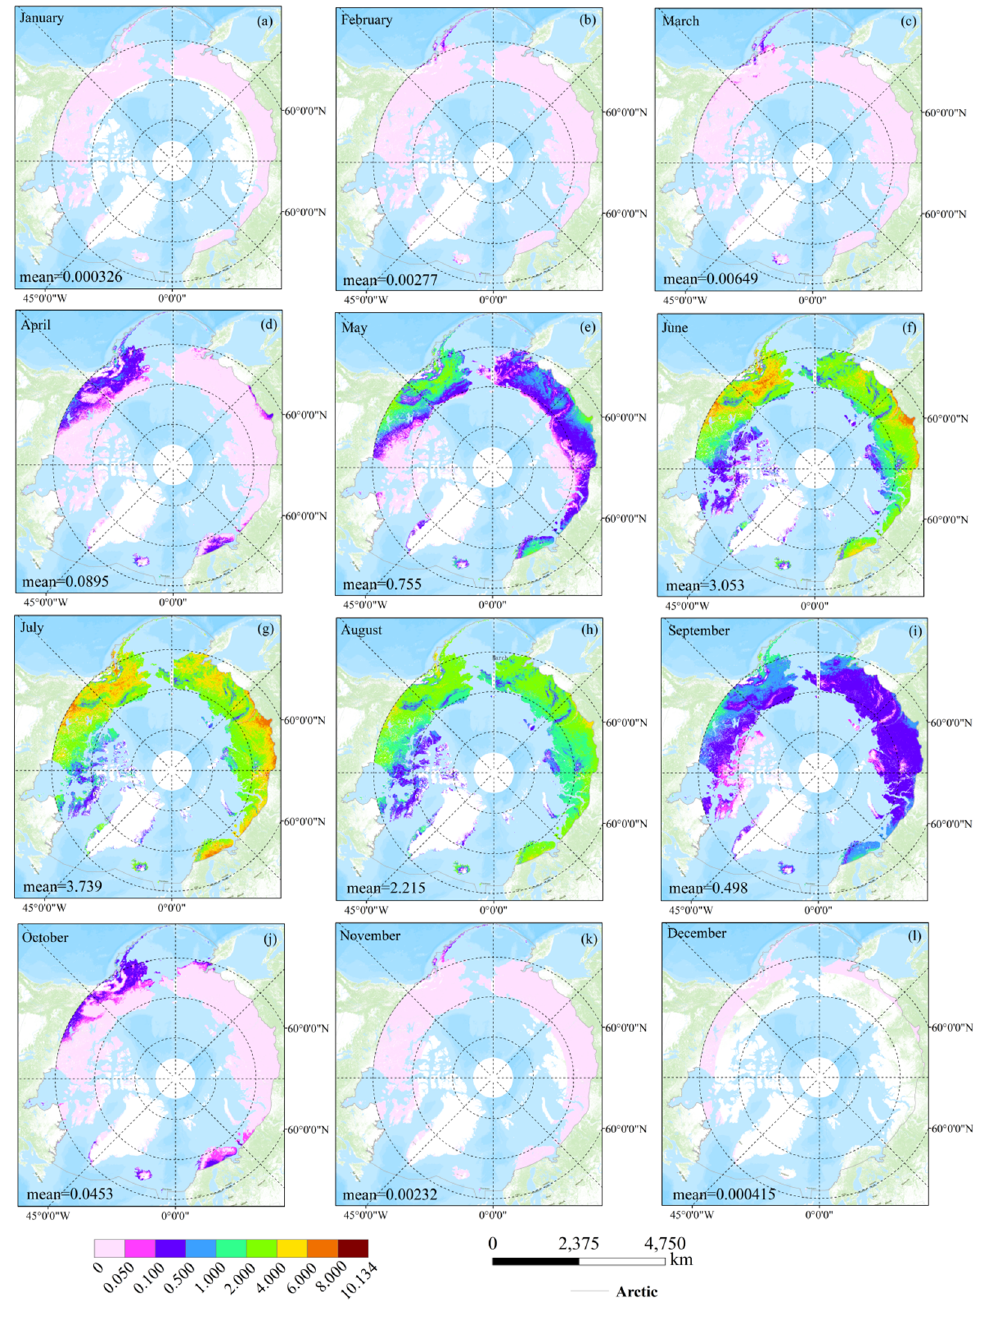
Figure 12. Spatial distribution characteristics of the multiyear averaged monthly GPP over the Arctic, ( a – l ) refers to January to December. The mean values of the whole Arctic are also shown in the figure for each month. Units of GPP are g C m − 2 d − 1 .